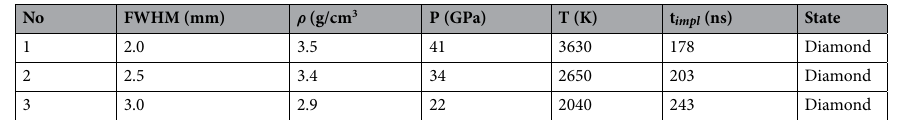
Table 12. Achieved physical conditions in compressed carbon using bunch intensity = 5 × 10 10 uranium ions, bunch length = 200 ns, particle energy = 2 GeV/u, initial sample radius, R si = 200 μm, sample mass = 2.8 mg/ cm.